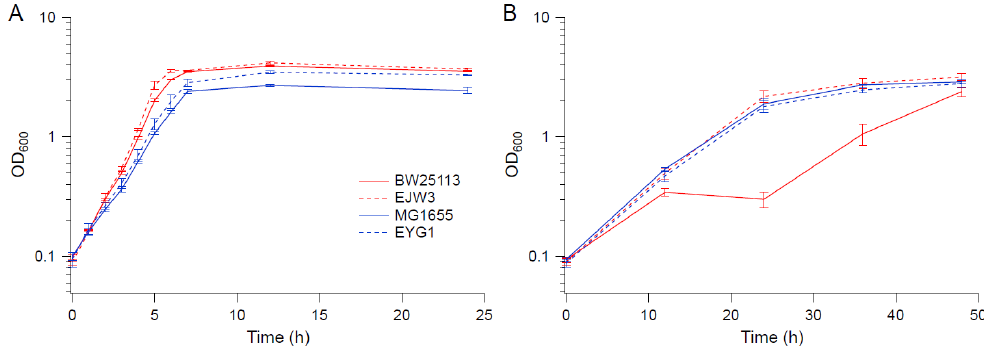
Figure 10. Growth kinetics of MG1655, EYG1, BW25113 and EJW3. ( A ) M9 ( B ) M9 supplemented with 0.6 M NaCl. Error bars are standard deviations.